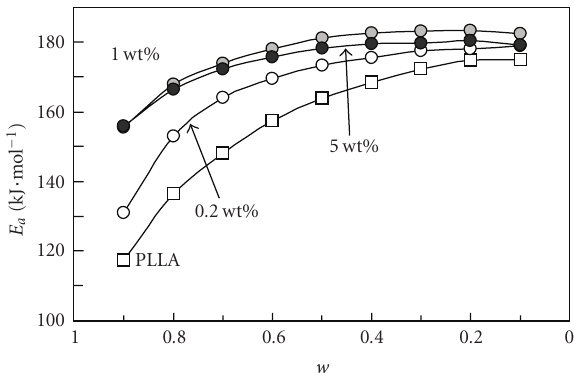
Figure 9: Activation energy, E a , plots against residual weight, w , of PLLA and PLLA component for thermal degradation of PLLA, PLLA/BHPP-0.2wt%, 1wt%, and 5wt% blends.